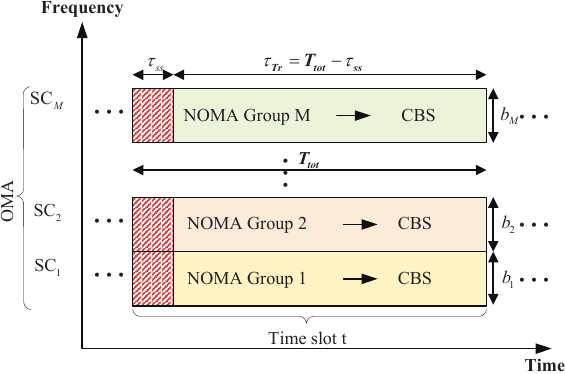
Figure 2. Time frame of the cognitive users’